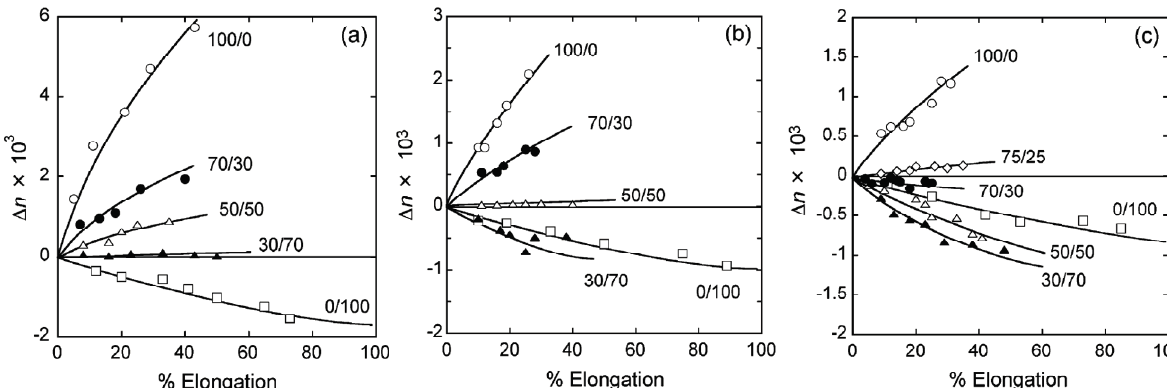
Figure 27. Birefringence of CA/P(VP- co -MMA) drawn films prepared at different DS and VP/MMA ratio as a function of elongation: ( a ) DS = 1.80 and VP/MMA = 35:65; ( b ) DS = 2.18 and VP/MMA = 47:53; ( c ) DS = 2.48 and VP/MMA = 50:50. Reprinted with permission from ref. [40]. Copyright 2007 American Chemical